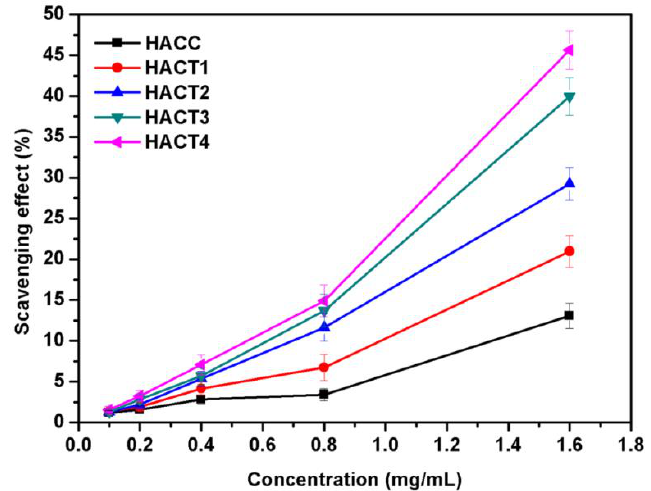
Figure 7. Hydroxyl radical scavenging activity of chitosan derivatives.